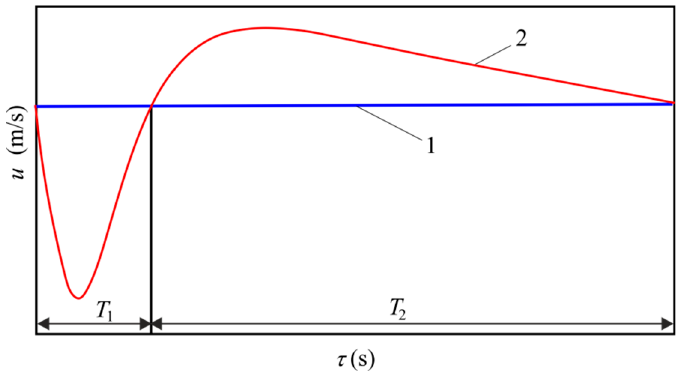
Figure 2. Pulsating asymmetric flow: 1—steady flow; 2—pulsating velocity. The pulsating frequency is found by equation: f = 1/ T